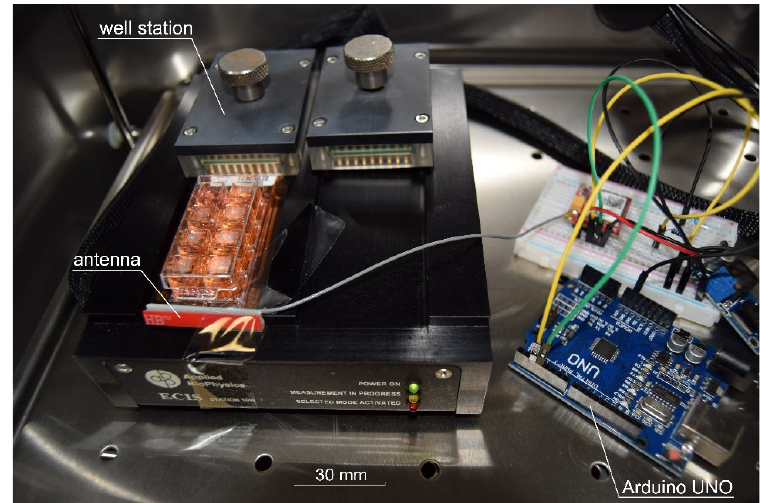
Figure 7. The ECIS arrays with cell culture wells placed in the holders of the measuring station with the antenna attached.